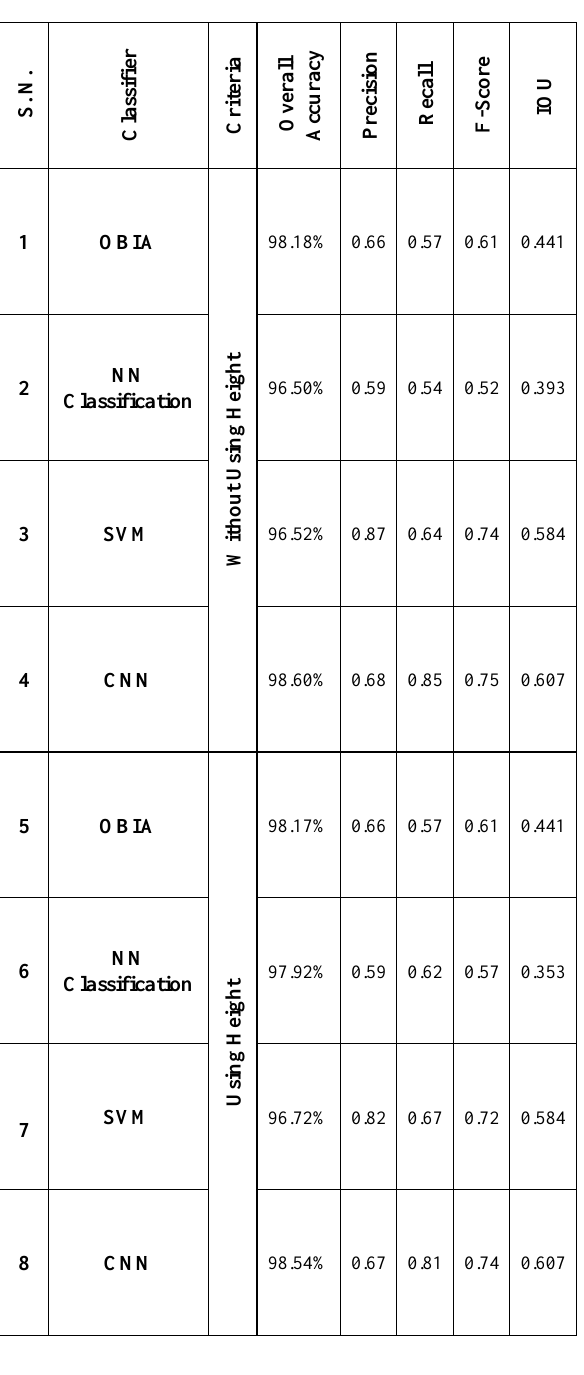
Table 1 . Performances Metrices Values of Classifier